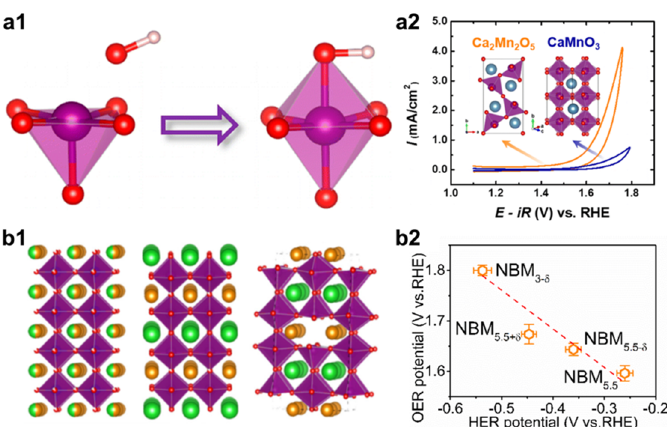
Figure 8. ( a ) Oxygen-deficient Ca 2 Mn 2 O 5 perovskite as an OER electrocatalyst: ( a1 ) The plausible effect of the oxygen vacancies in Ca 2 Mn 2 O 5 on the OER kinetics and ( a2 ) the structure and OER CV; reproduced with permission [43] Copyright (2014), American Chemical Society. ( b ) Orthorhombic NdBaMn 2 O 5.5 as a bifunctional OER and HER catalyst: ( b1 ) The structure (from the left to the right) of Nd 0.5 Ba 0.5 MnO 3-δ , NdBaMn 2 O 5.5-δ , and NdBaMn 2 O 5.5 and ( b2 ) the OER and HER onset potential